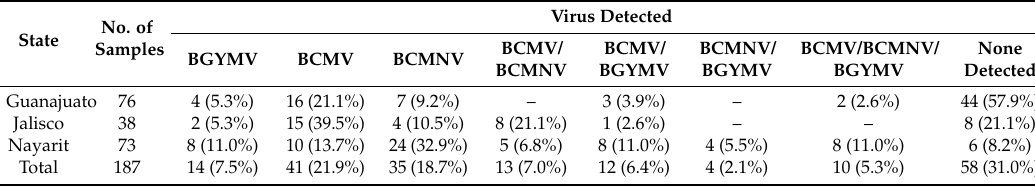
Table 2. Detection BGYMV, BCMV, and BCMNV in common bean samples collected in rainfed commercial bean fields from Guanajuato, Jalisco, and Nayarit